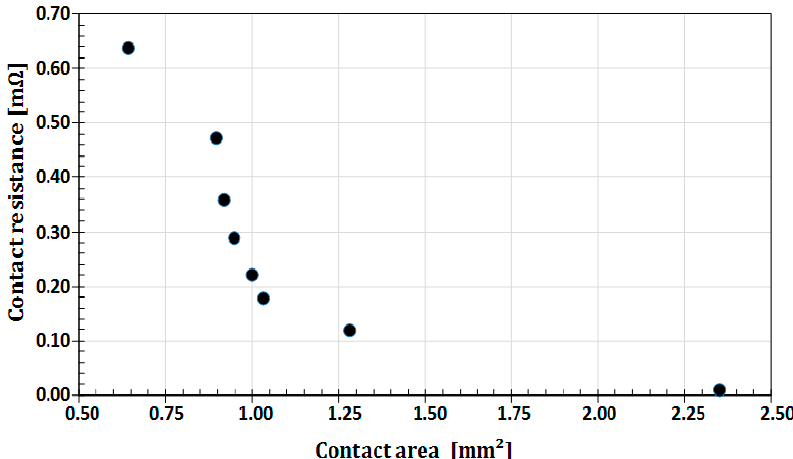
Figure 9. Contact resistances as a function of the areas’